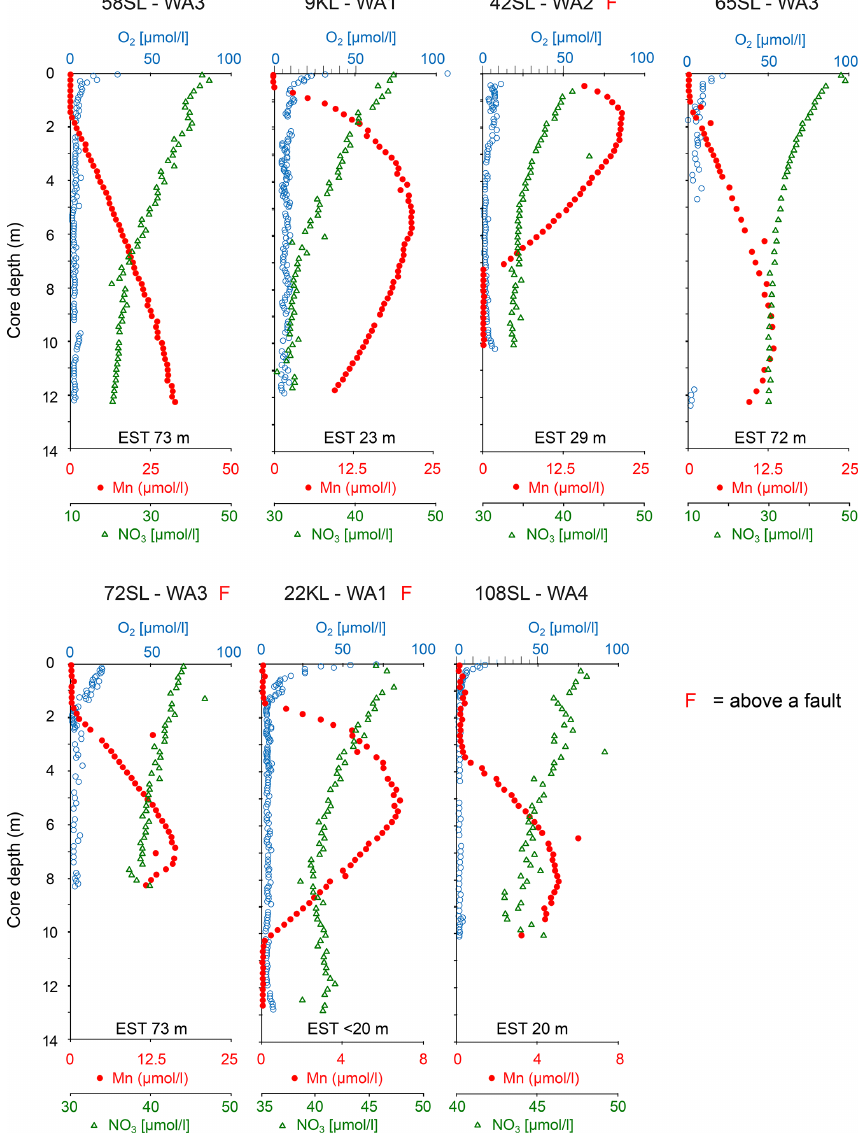
Figure 3. Dissolved oxygen, manganese and nitrate profiles of cores with free porewater manganese in order of maximum manganese con- centrations (decreasing minimum nitrate values). For all cores nitrate values reach below the inferred value for basement fluid of 45µmolL − 1 , suggesting the sediments at these locations are nitrate sinks. Core 22KL illustrates this with a nitrate minimum at 7m core depth, indicating the depth where denitrification equals the nitrate fluxes from above and below. EST denotes estimated sediment thickness for each core (from Table